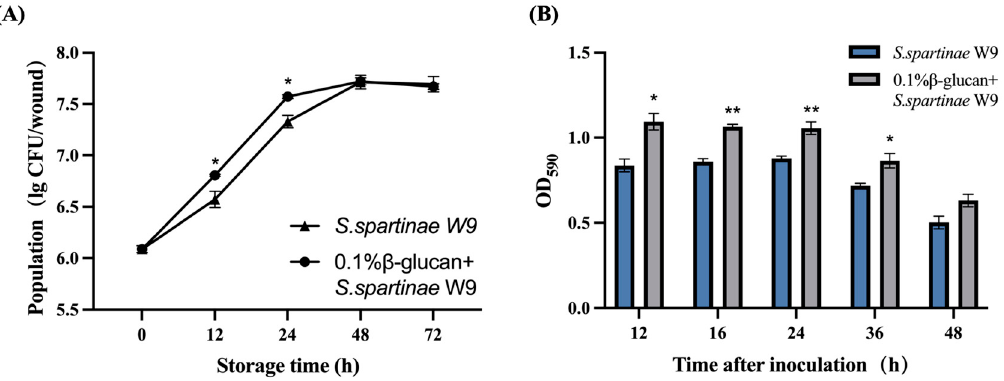
Figure 3. E ff ects of 0.1% β -glucan on colonization ability in strawberries and bio fi lm forming ability of S.spartinae W9. ( A ) Population dynamics of S. spartinae W9 cultured in NYDB or NYDB with 0.1% β -glucan in wounds of strawberries at 20 °C. ( B ) Bio fi lm forming ability of S. spartinae W9 cultured with or without 0.1% β -glucan stained with crystal violet. Asterisks indicate a signi fi cant di ff erence between S. spartinae W9 cultured with or without 0.1% β -glucan identi fi ed by the t-test (*, p < 0.05; **, p < 0.01).